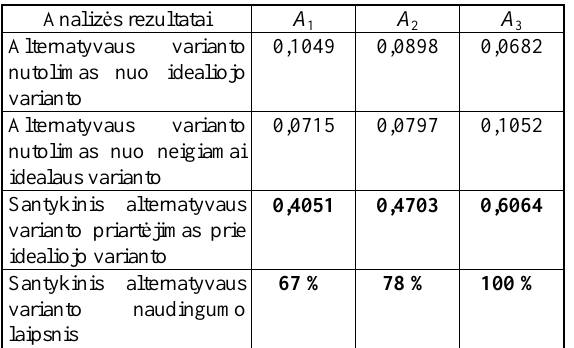
Table 2. Selecting the best site for revitalisation of derelict rural buildings Analiz ė s